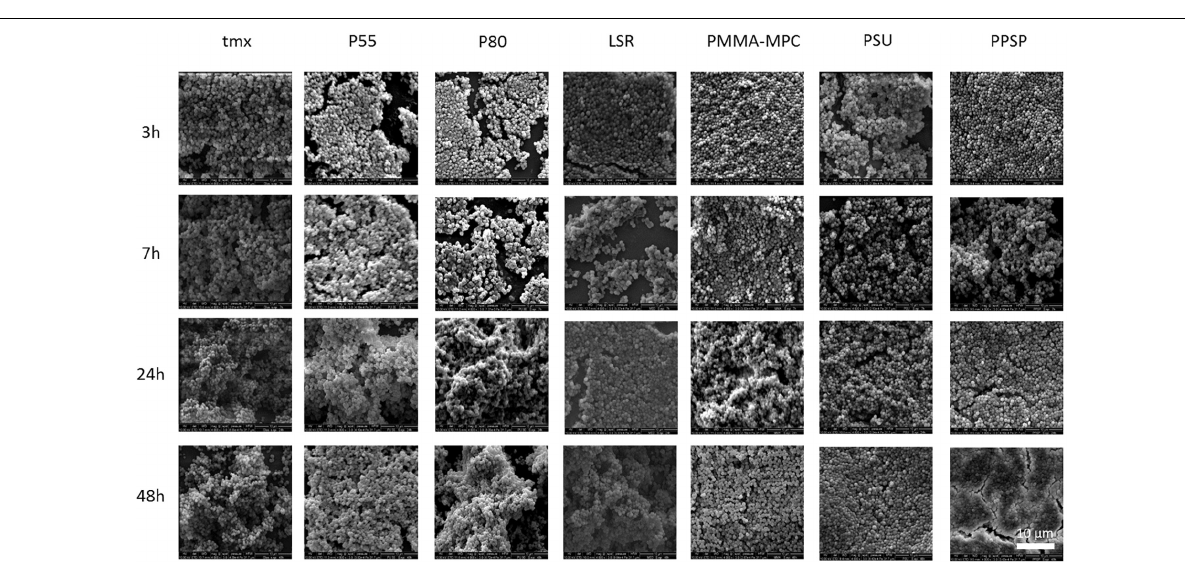
FIGURE 5 | Investigated materials have no influence on S. epidermidis colonialization. Materials were incubated with 2 × 10 8 CFUs of S. epidermidis and colonialization was analyzed after 3, 7, 24, and 48 h by SEM. Magnification, ×